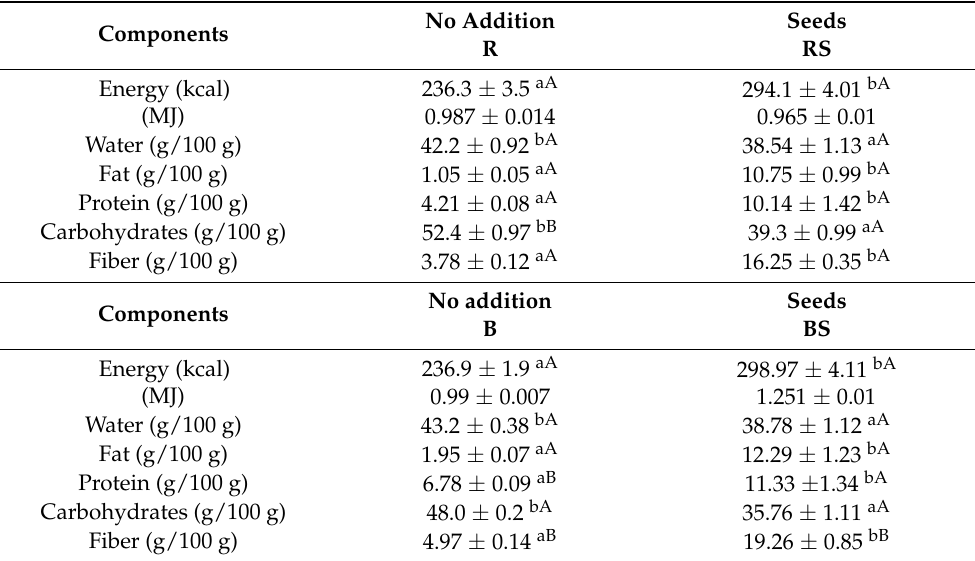
Table 2. The energy value and the content of macronutrients in the main breads (rice and buck- wheat) [2] and breads with